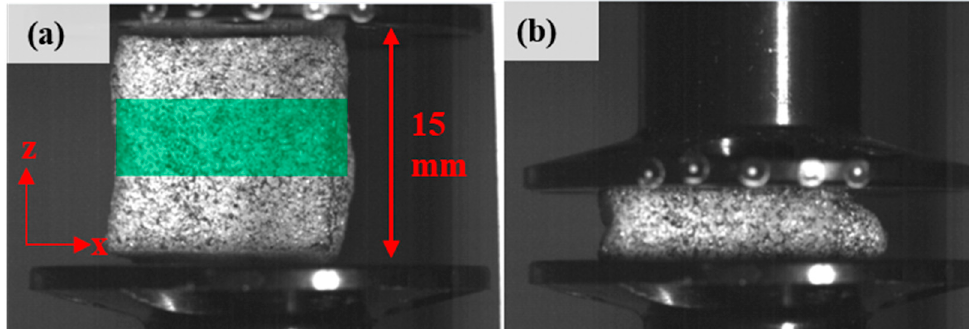
Figure 2. Auxetic closed cell foam in compression test device, ( a ) uncompressed with target region for DIC; and ( b ) at 80% compression.